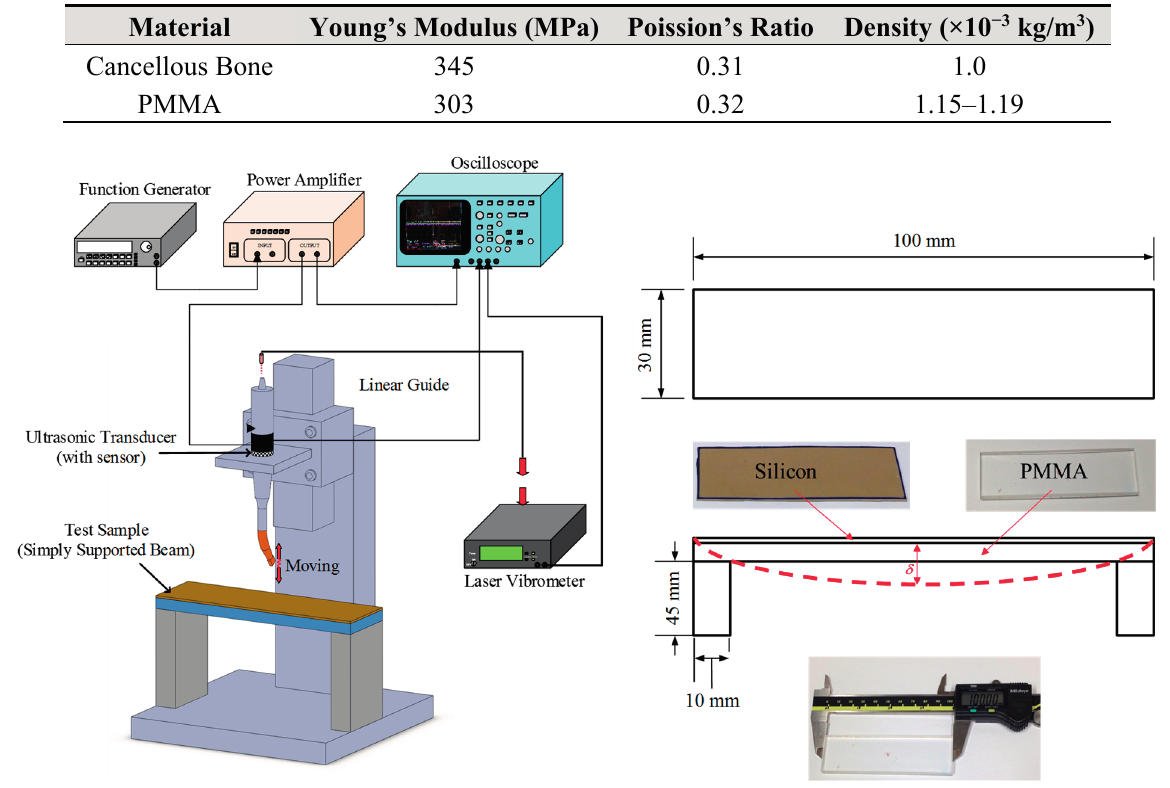
Table 3. Properties of cancellous bone and polymethyl methacrylate (PMMA).